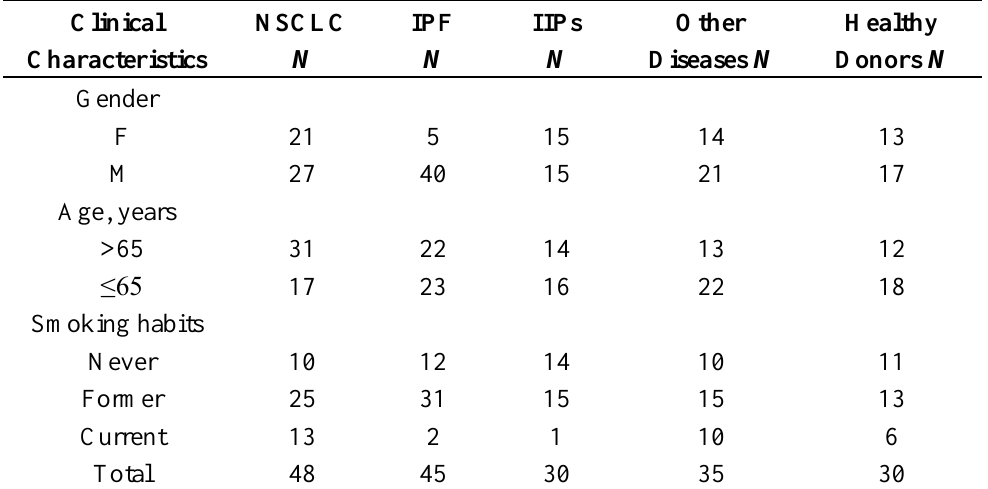
Table 1. Clinical characteristics of patients and healthy